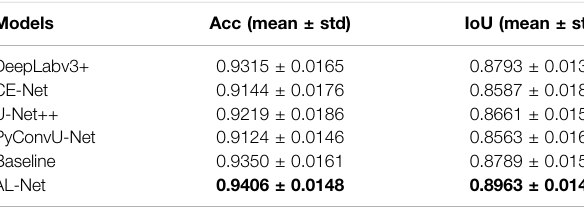
Bold represents the best